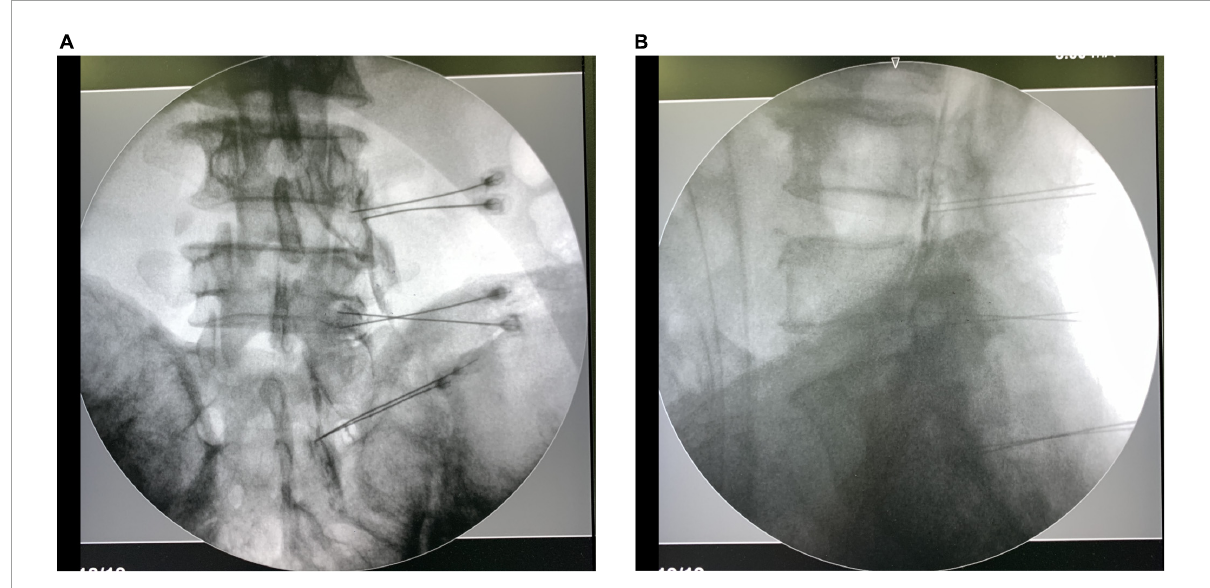
FIGURE1 Anteroposterior of and lateral C-arm fluoroscopy images with needle placement, and spread of contrast medium at dorsal root ganglion and epidural space.